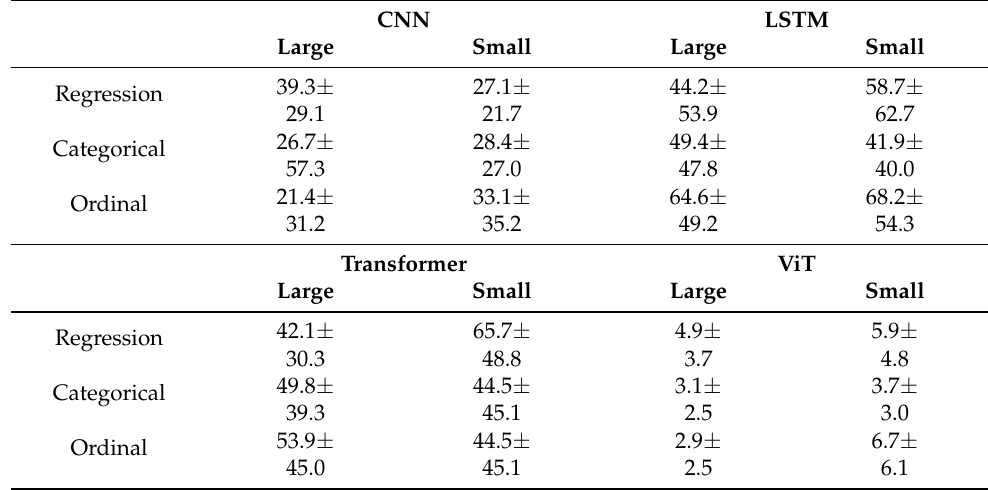
Table 3. Neural network results on test data from February 17. The results indicate the mean distance in meters between the predicted results by the neural network and the recorded results by the GPS. A ± 1 σ deviation is shown.